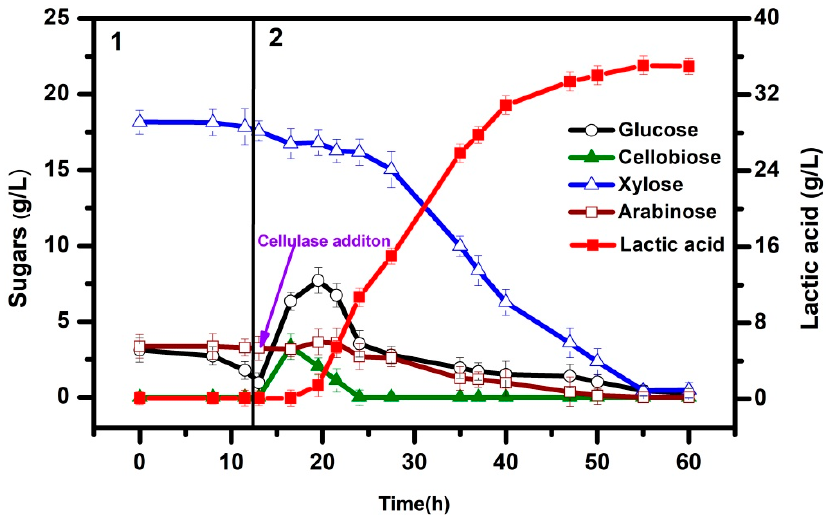
Figure 4. Profile of two-step SSCF with PAS by B. coagulans IPE22. During step 1, fermentation was conducted at 50 ◦ C, 150 r/min and pH was not controlled. During step 2, fermentation was conducted at 50 ◦ C, 150 r/min and pH 5.0. Cellulase loading was 20 FPU per gram cellulose during SSCF process. Symbols represent: lactic acid, filled squares; glucose, open circles; xylose, open triangles; arabinose, open squares; cellobiose, filled triangles.